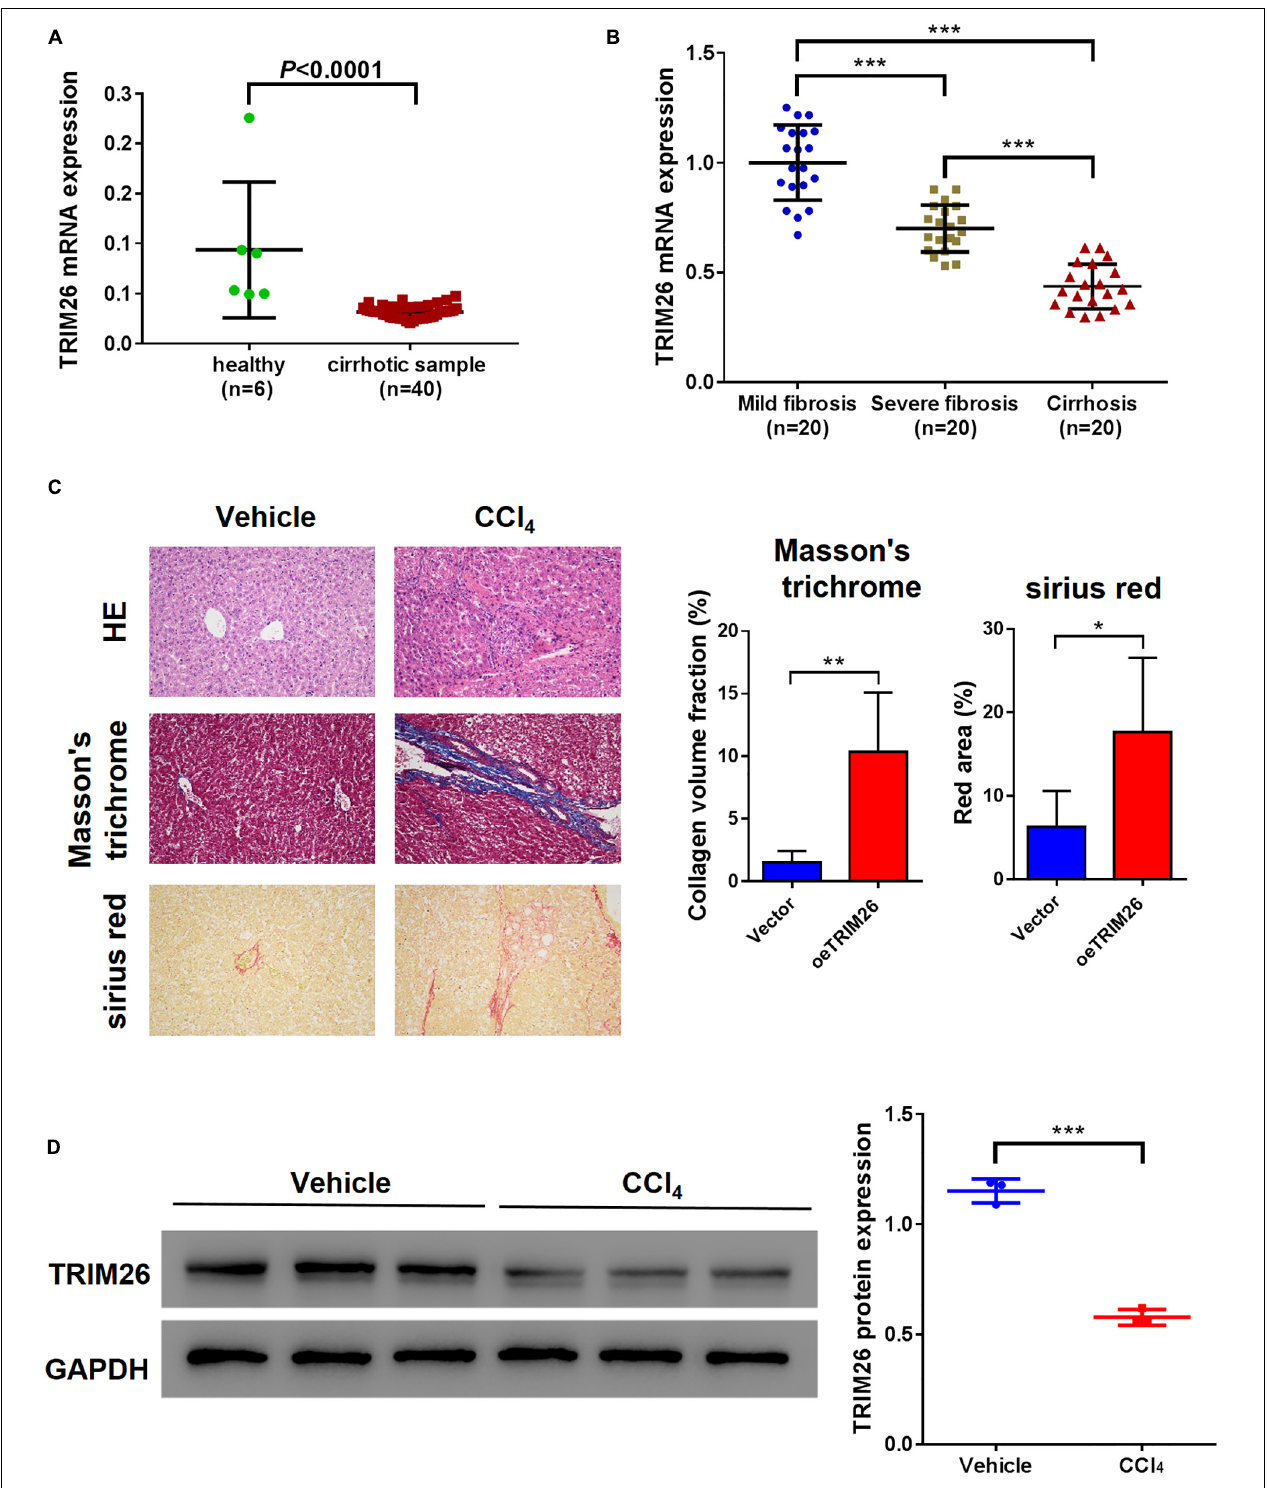
FIGURE 1 | TRIM26 expression in fibrotic liver tissues. (A) mRNA level of TRIM26 in normal and cirrhotic liver samples, according to GSE25097 dataset. (B) mRNA level of TRIM26 in human mild-fibrotic, severe-fibrotic, and cirrhotic liver samples by qRT-PCR. (C,D) Mice liver fibrosis model was established by CCl 4 induction. (C) histological examination (magnification at 200 × ) of liver tissues by hematoxylin and eosin, Masson’s trichrome, and Sirius red staining; The qualification of Masson’s trichrome and Sirius Red staining was performed with ImageJ software. (D) protein expression of TRIM26 by western blot analysis. * P < 0.05, ** P < 0.01, *** P <